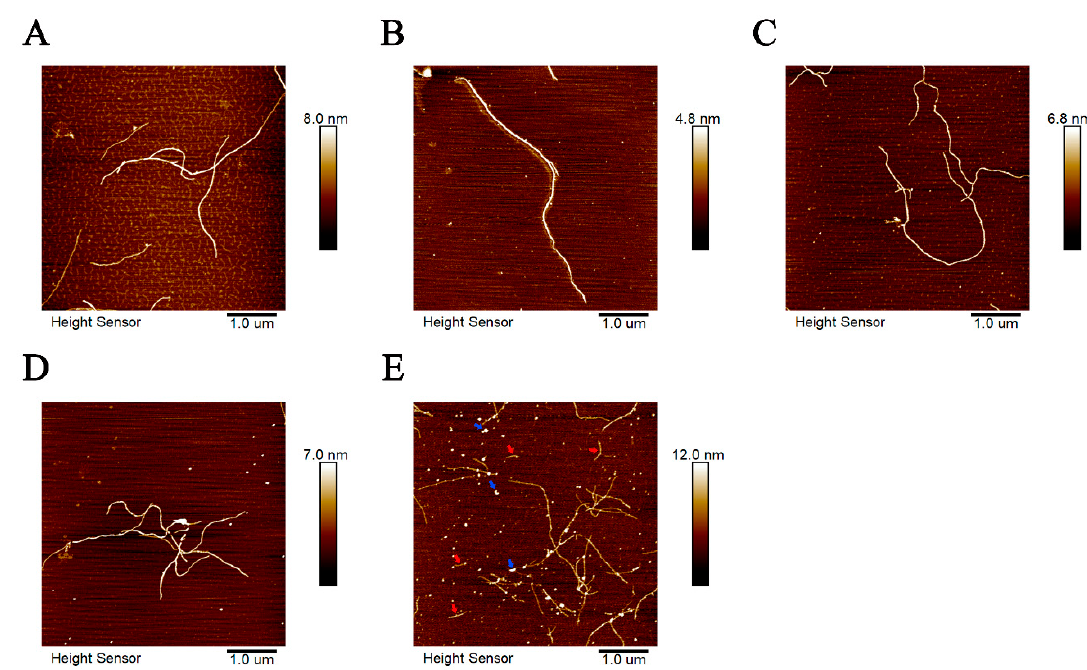
Figure 5. Atomic force microscope (AFM) images of tau-R3 aggregations formed with or without cations (( A ) tau-R3; ( B ) Mn 2+ +R3; ( C ) Mo 5+ +R3; ( D ) Fe 3+ +R3; and ( E ) Zn 2+ +R3). Tau-R3 (50 μ M) was incubated with heparin (16 μ M) in the presence or absence of metal ions (10 μ M) at 37 °C for 24 h. Then, each sample was diluted 50 times. Shorter filaments were indicated with red arrows and oligomers with blue arrows. The scale bars represent one μ m.